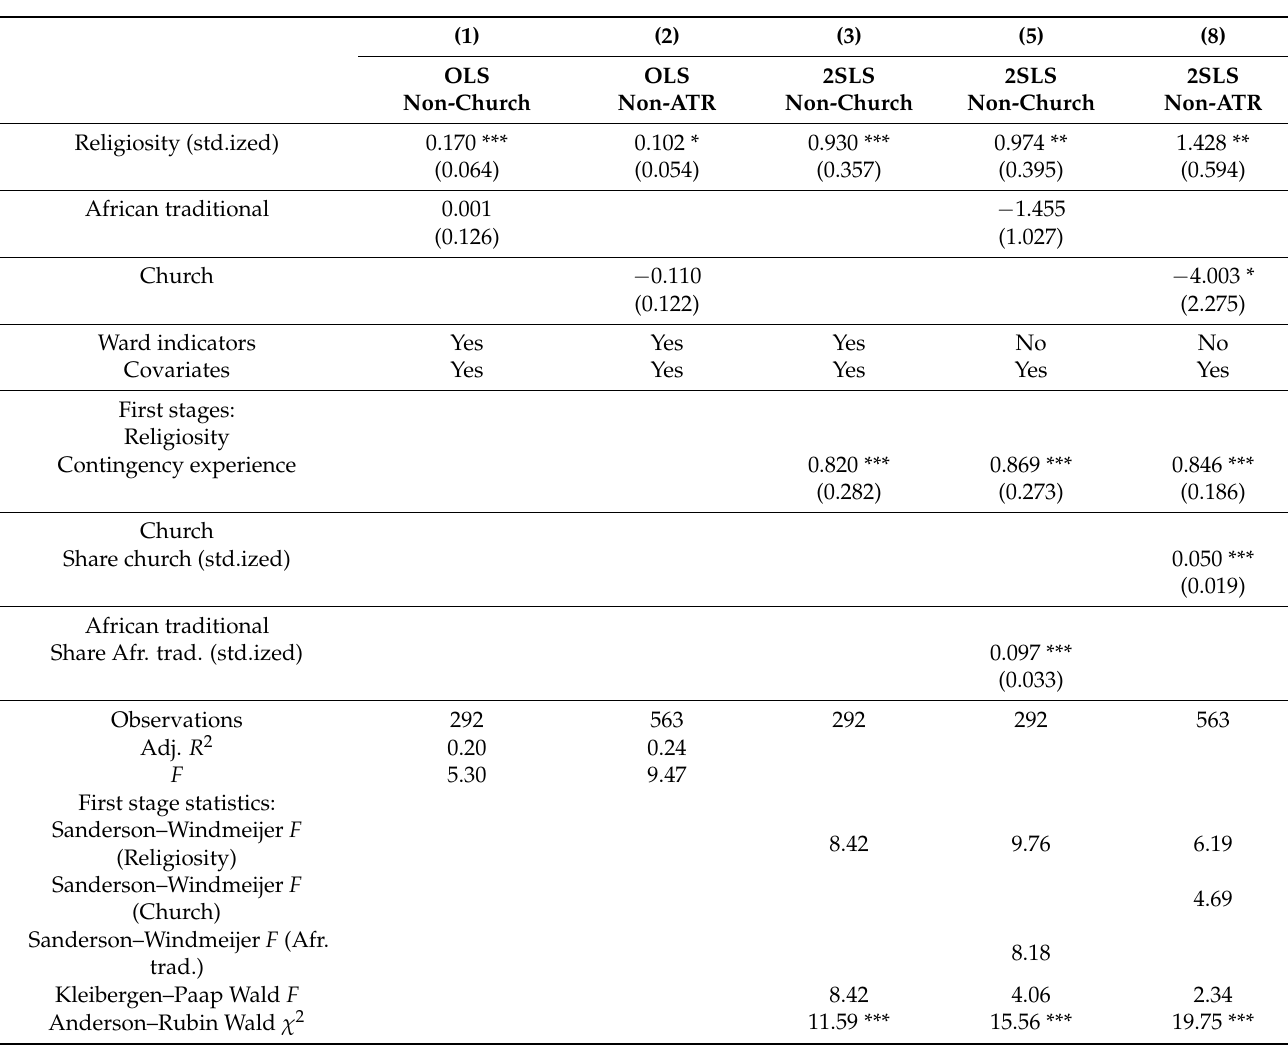
Table A7. Estimation results least squares estimation for subsamples of non-church members and non-ATR